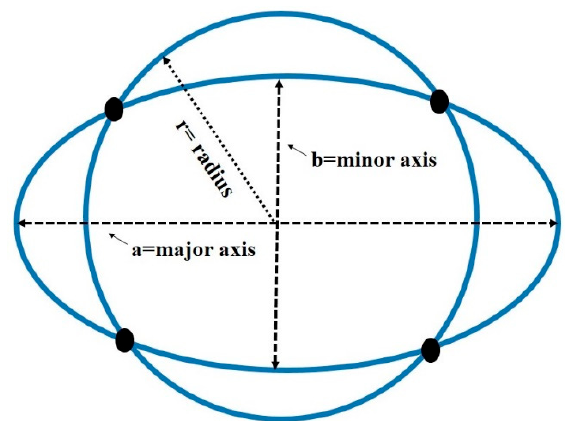
Figure 1. Anatomy of two equi-central radiators.